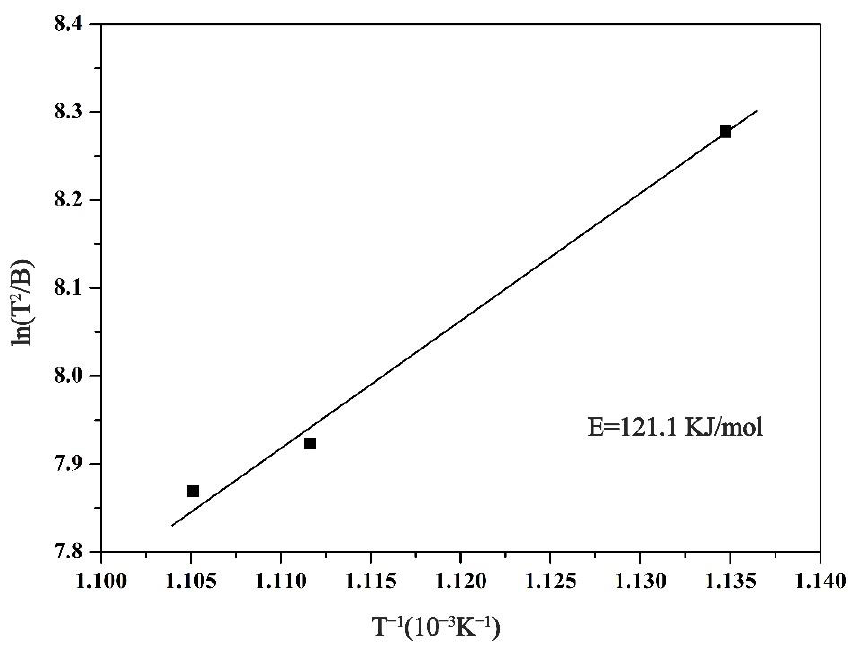
Figure 3. Kissinger curve of the (Nd 0.525 Pr 0.175 Ce 0.3 ) 9 Fe 64.5 Co 3 Cu 0.5 Ti 1 B 22 as-spun ribbons.